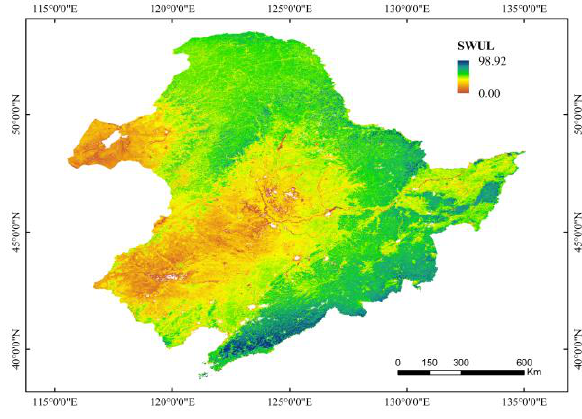
Figure 3. Spatial pattern of SWUL in NEC